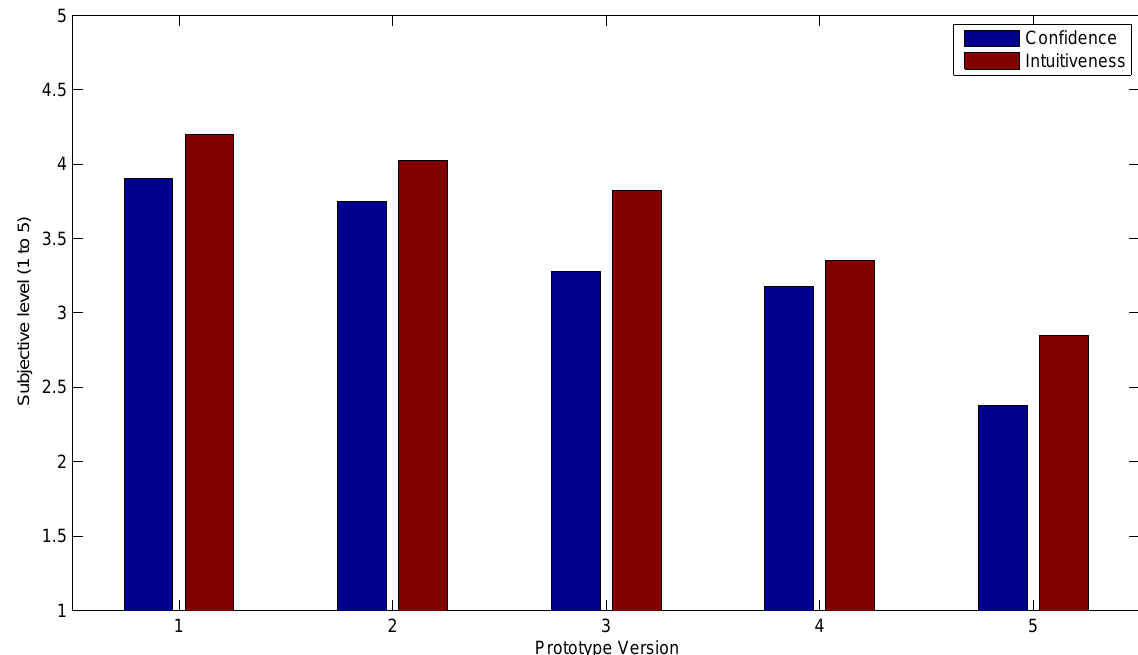
Figure 10. Subjective evaluation of the prototypes in terms of confidence level and intuitiveness, showing a lower rating for a lower sensor